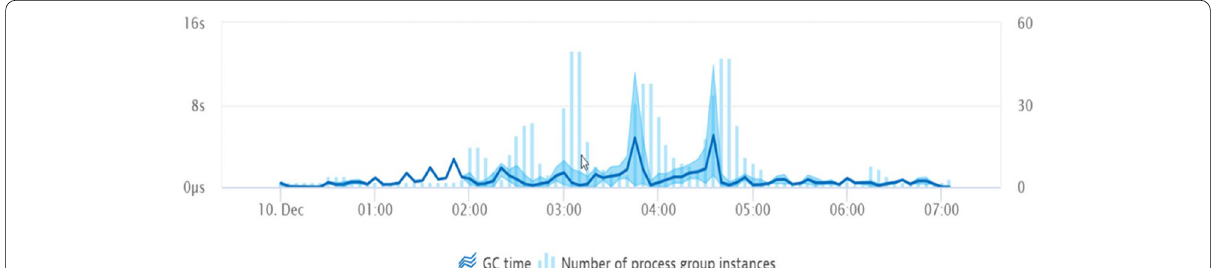
Fig. 24 Garbage collection time vs. number of microservice frontend